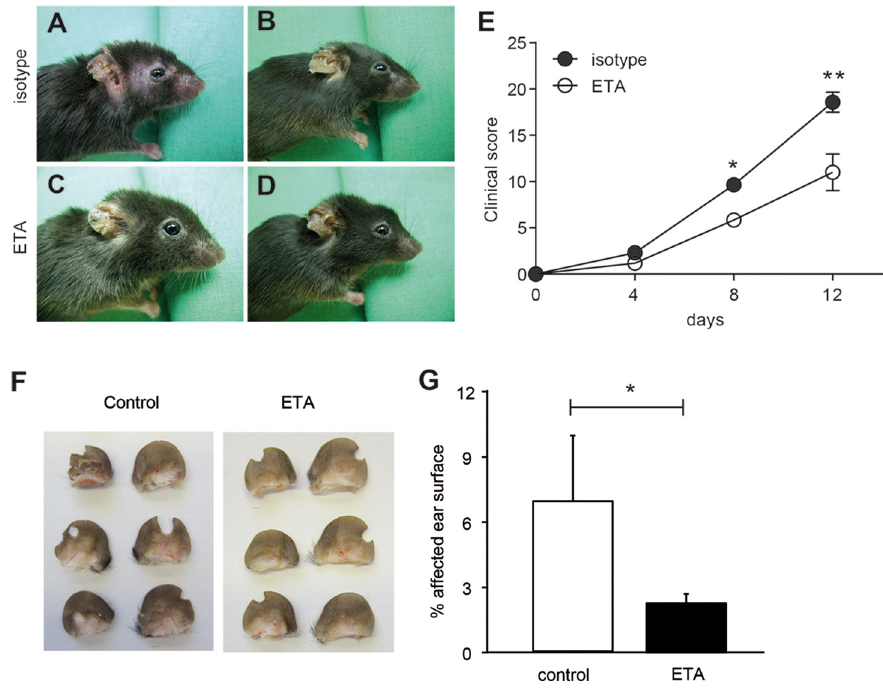
Figure 3. Prophylactic inhibition of TNF using ETA in antibody transfer–induced EBA